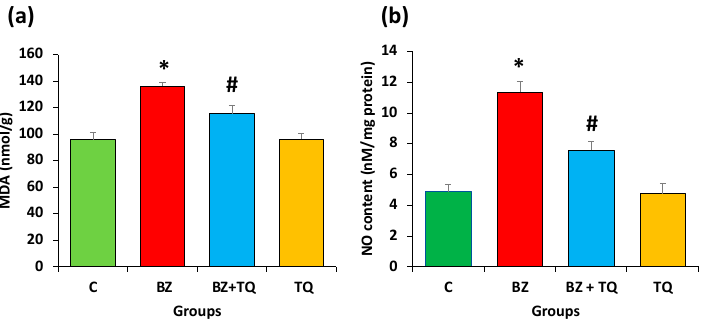
Figure 3. ( a ) The level of MDA was considerably increased in the animal group intoxicated with only B(a)P in comparison with the control group. TQ treatment significantly decreased the MDA level compared to the group treated with B(a)P only. ( b ) The NO concentration was considerably amplified in the group treated with B(a)P only compared to the control animals. TQ treatment decreased the NO level significantly in comparison with the B(a)P-treated group. The values denote the mean ± SEM, with 8 rats/group. The statistical differences are denoted with an asterisk (*), indicating significance at p < 0.05 in comparison with the control group, and a hashtag (#), signifying p < 0.05 in comparison with the disease control.